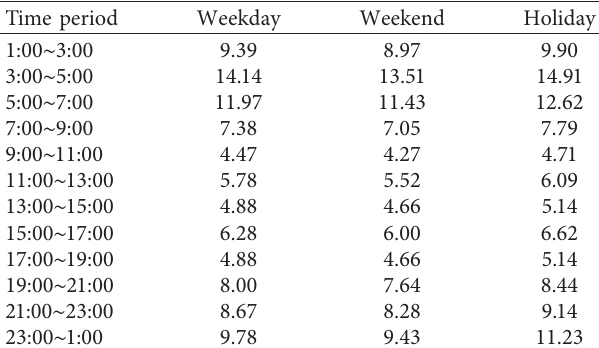
Table 11: Average passenger-seeking distance in different time